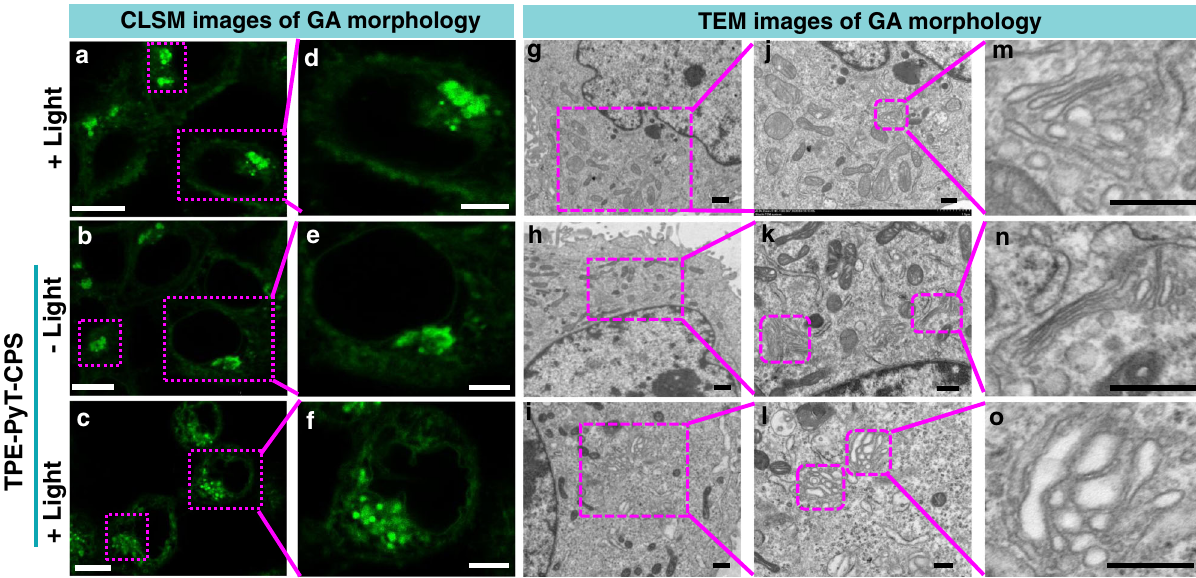
Fig. 6 Morphological changes of Golgi apparatus after oxidative stress upon PDT treatment. Morphological changes of GA observed by ( a – f ) CLSM (stained with Gogli Green) and TEM ( g – o ) imaging in HeLa cells after treatment with light only, TPE-PyT-CPS (0.2 μ M) with or without light irradiation (25 mW cm − 2 , 2 min). The experiments were performed three times independently, representative images are shown. Scale bars for a – c : 10 μ m; d – f : 5 μ